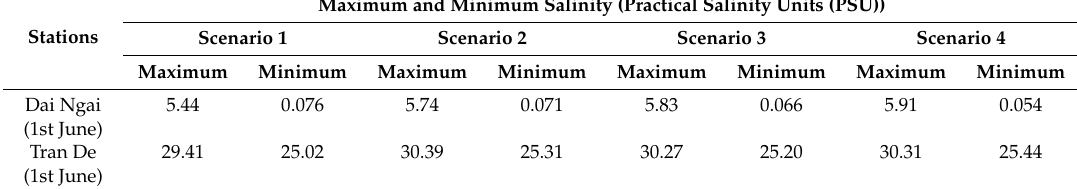
Figure 9. Spatial distribution of maximum salinity level across the modelling domain under Scenario 1 ( a ), Scenario 2 ( b ), Scenario 3 ( c ) and Scenario 4 ( d ). Table 6. Maximum and minimum salinity concentration at Dai Ngai and Tran De stations.